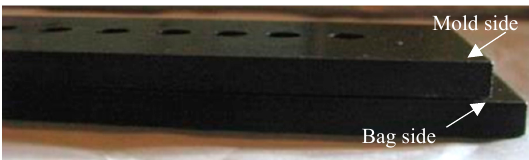
Figure 1. Carbon fiber-reinforced plastic (CFRP) / CFRP laminate stack for drilling experimentation: mold side (smooth surface); bag side (irregular surface). Table 1. Experimental drilling conditions.